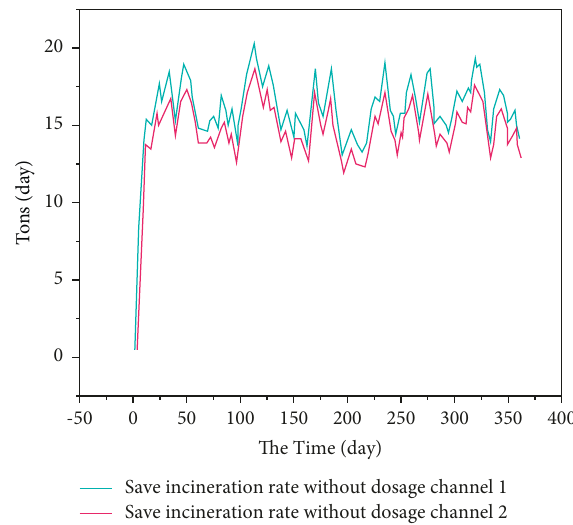
Figure 15: Comparison of incineration rates without